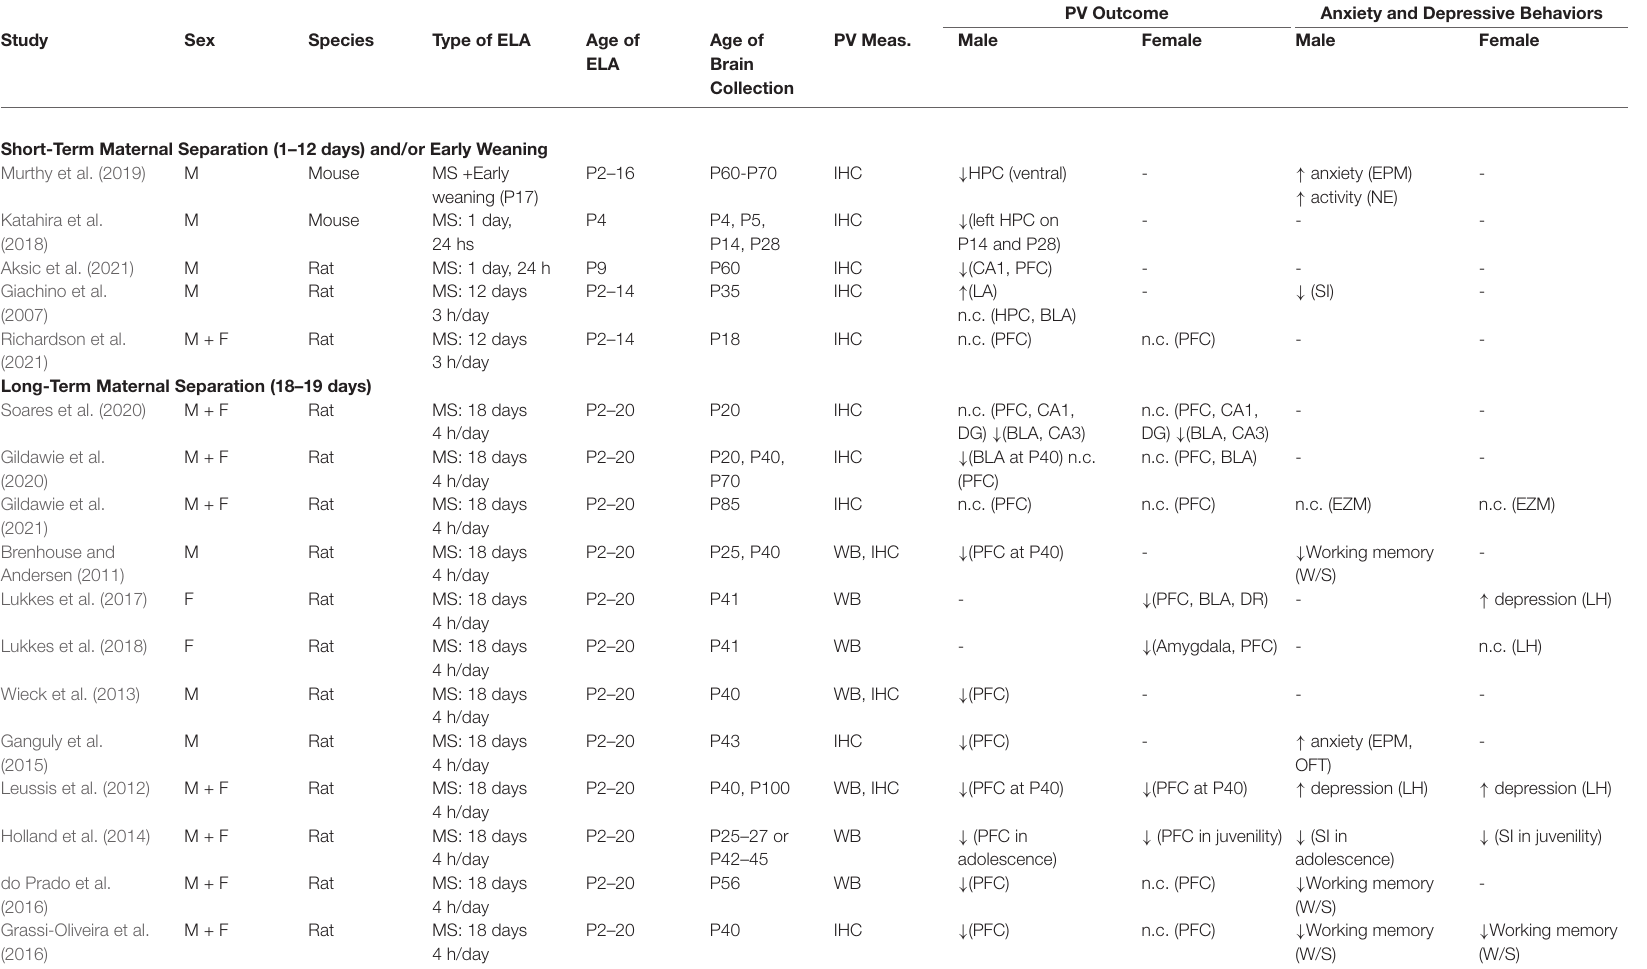
TABLE 1 | PV and behavioral outcomes as a function of sex, age, and ELA type.